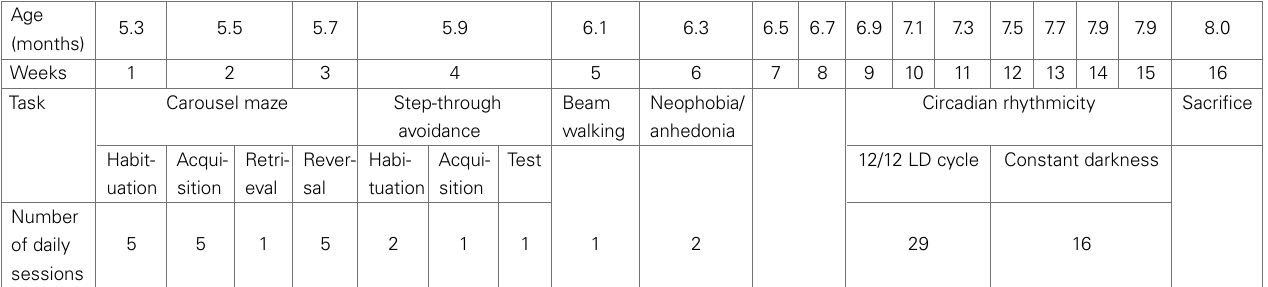
Table 1 |Time schedule of behavioral experiments